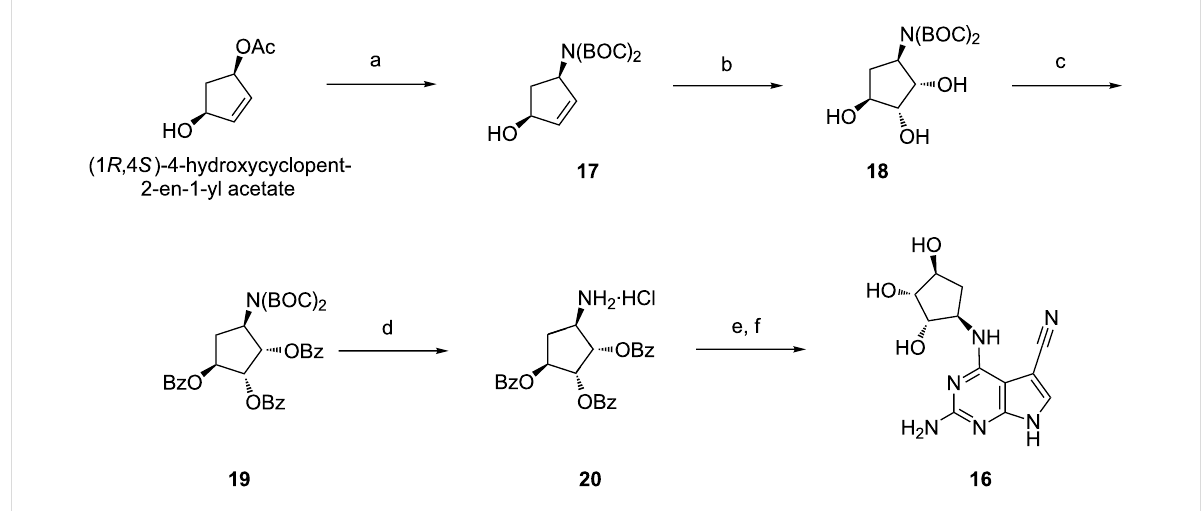
Figure 5: Synthesis of 16 , a (1 S ,2 R ,3 S ,4 R )-4-aminocyclopentane-1,2,3-triol derivative of PreQ 0 . Reagents and conditions: (a) Pd(PPh 3 ) 4 , PPh 3 , NaH, NH(Boc) 2 , THF/DMF, 1 day, 50 °C, 42%; (b) OsO 4 , NMO, acetone/H 2 O, 1 day, rt, 83%; (c) BzCl, pyr, 17 h, 0 °C to rt, 74%; (d) 4 M HCl in 1,4- dioxane, 16 h, 0 °C to rt, 76%; (e) 9 , Et 3 N, n -BuOH, 16 h, 130 °C; (f) KOH, n -BuOH/EtOH, 16 h, 80 °C,